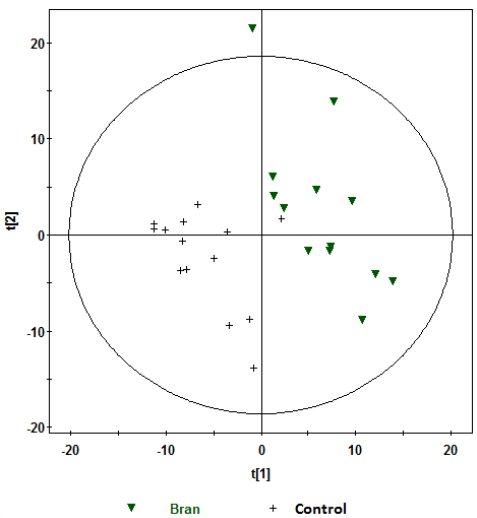
Figure 4. PLS-DA scores plot (t[1]) vs. t[2]) obtained from 1 H NMR spectra of postprandial urine a multiple correlation coefficient ( R 2 ) an estimate of goodness of fit of model to the data; b cross Figure 5. PLS-DA scores plot (t[1]) vs. t[2]) obtained from 1 H NMR spectra of postprandial urine Figure 5. PLS-DA scores plot (t[1]) vs. t[2]) obtained from 1 H NMR spectra of postprandial urine Figure 5. PLS-DA scores plot (t[1]) vs. t[2]) obtained from 1 H NMR spectra of postprandial urine Figure 3. PLS-DA scores plot (t[1]) vs. t[2]) obtained from 1 H NMR spectra of postprandial urine samples of aleurone vs. control at two hours (Observations ( n ) = 24), , aleurone; , control. validation correlation coefficient ( Q 2 ) an estimate of goodness of prediction; c average % of samples samples of bran vs. control at one hour (Observations ( n ) = 27), , bran; , control. Variables ( K ) = samples of bran vs. control at one hour (Observations ( n ) = 27), , bran; , control. Variables ( K ) = 181. samples of bran vs. control at one hour (Observations ( n ) = 27), , bran; , control. Variables ( K ) = samples of aleurone vs. control at one hour (Observations, n = 27), , aleurone; , control. Variables correctly classified during cross validation. 181. PLS component 1: R 2 = 0.204, Q 2 = 0.51; PLS component 2: R 2 = 0.176, Q 2 = 0.111. The ellipse PLS component 1: R 2 = 0.204, Q 2 = 0.51; PLS component 2: R 2 = 0.176, Q 2 = 0.111. The ellipse represents 181. PLS component 1: R 2 = 0.204, Q 2 = 0.51; PLS component 2: R 2 = 0.176, Q 2 = 0.111. The ellipse (K) = 181. PLS component 1: R 2 = 0.196, Q 2 = 0.315; PLS component 2: R 2 = 0.18, Q 2 = 0.117. The ellipse represents 95% confidence region of the model based on Hotelling T 2 . 95% confidence region of the model based on Hotelling T 2 . represents 95% confidence region of the model based on Hotelling T 2 . represents 95% confidence region of the model based on Hotelling T 2 . Nutrients 2016 , 8 , 96